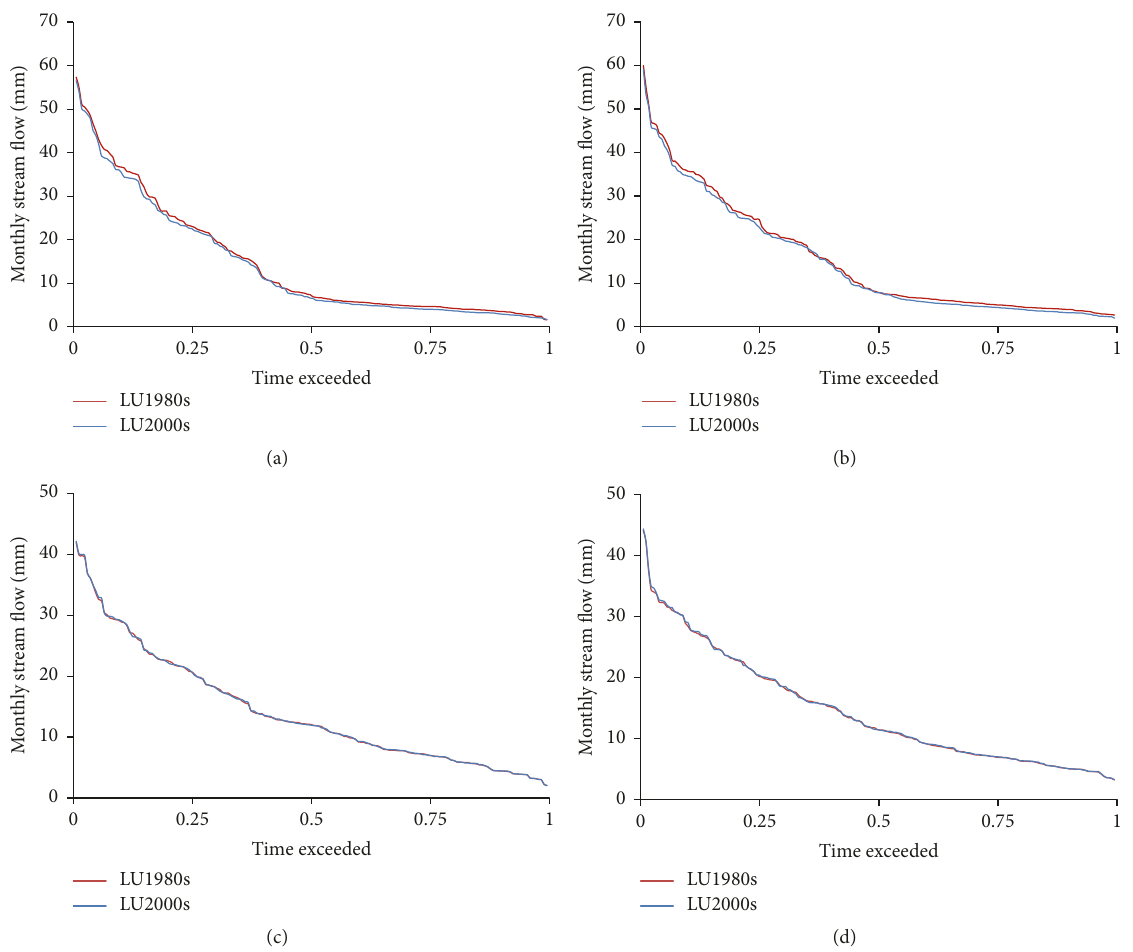
Figure 8: Impact of LUCC on flow duration curve in YLC in (a) 1982–1995 and (b) 1996–2010 and in MXC in (c) 1982–1995 and (d)